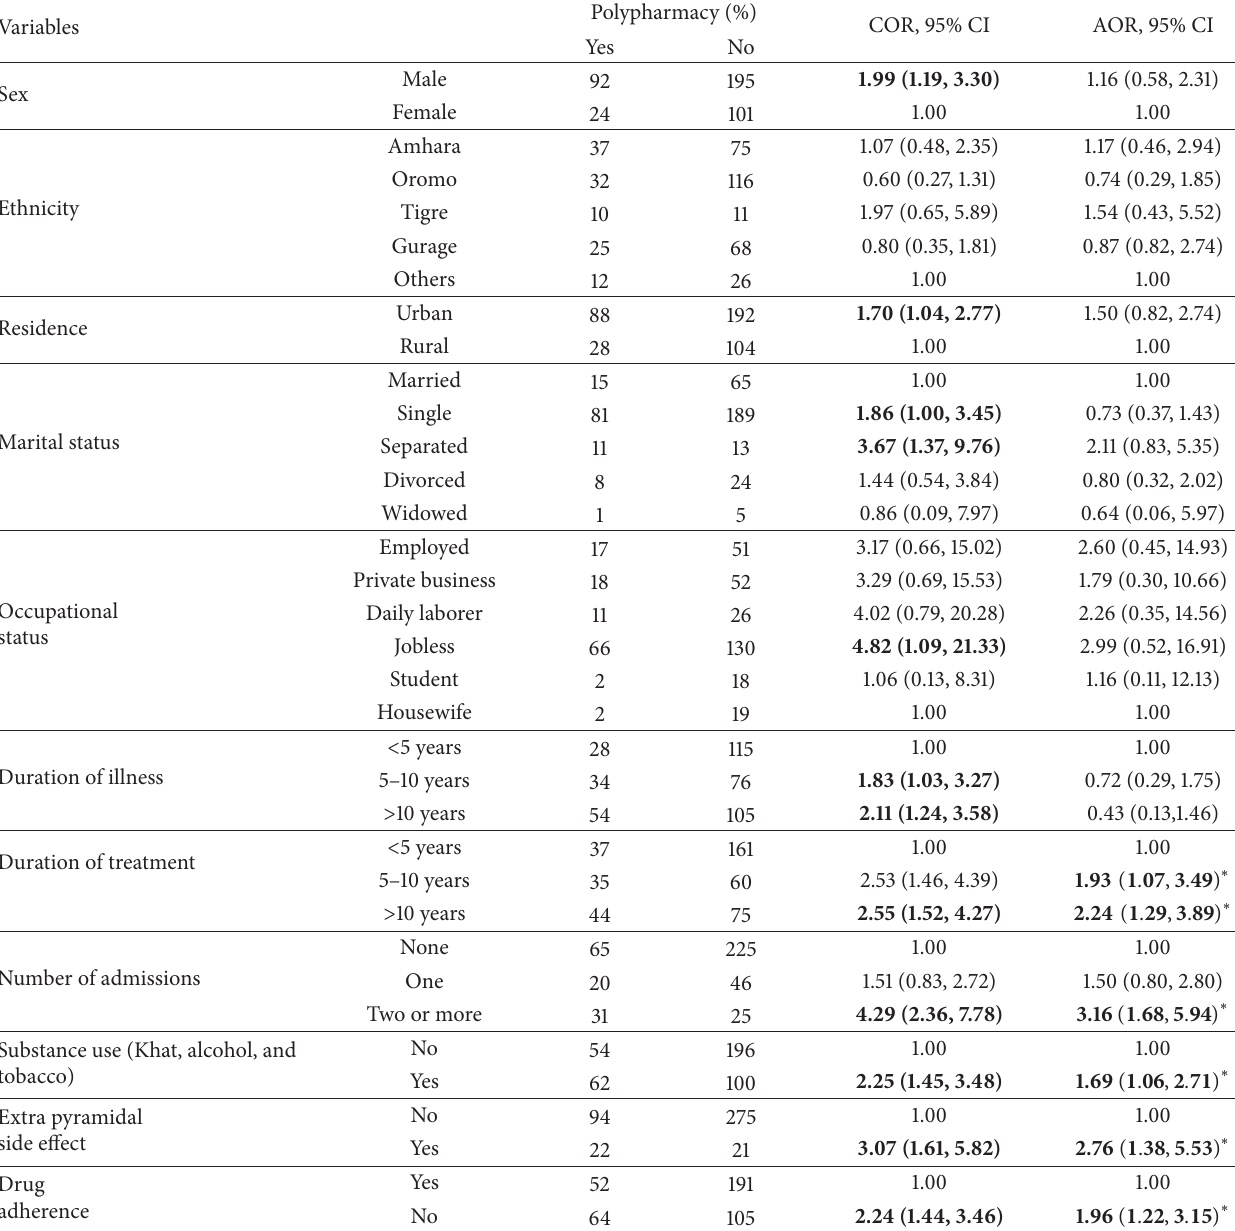
Table 3: Factors associated with antipsychotic polypharmacy among schizophrenia outpatients under follow-up at AMSH Addis Ababa, Ethiopia, June 2014 ( 𝑛 = 412